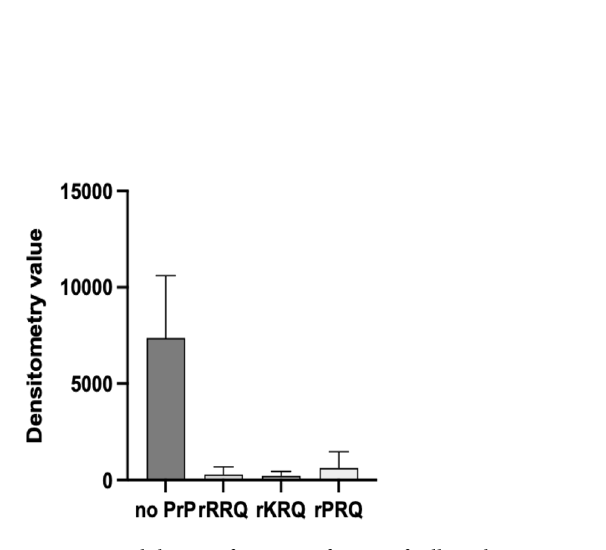
Figure 5. Inhibition of scrapie infection of cells with rPrPs. Rov9 cells expressing ovine VRQ/VRQ PrP C were inoculated with SSBP/1 scrapie brain homogenate with or without the presence of 250 nM of rRRQ, rKRQ or rPRQ. After a single passage, cell lysate containing 500 µg of total protein was PK-digsted and analysed for PrP Sc levels by western blot. Uninhibited cell infections were carried out in the absence of any rPrP as a control. The experiment was repeated three times for inhibition with rRRQ and twice for inhibition with rKRQ and rPRQ. Densitometry analysis of PrP Sc signals were calculated and average signals with SD are shown. One-way ANOVA with Dunnett’s multiple comparison was applied and indicated significantly lower PrP Sc signal for cells treated with 250 nM rRRQ, rKRQ and rPRQ compared to the no rPrP control